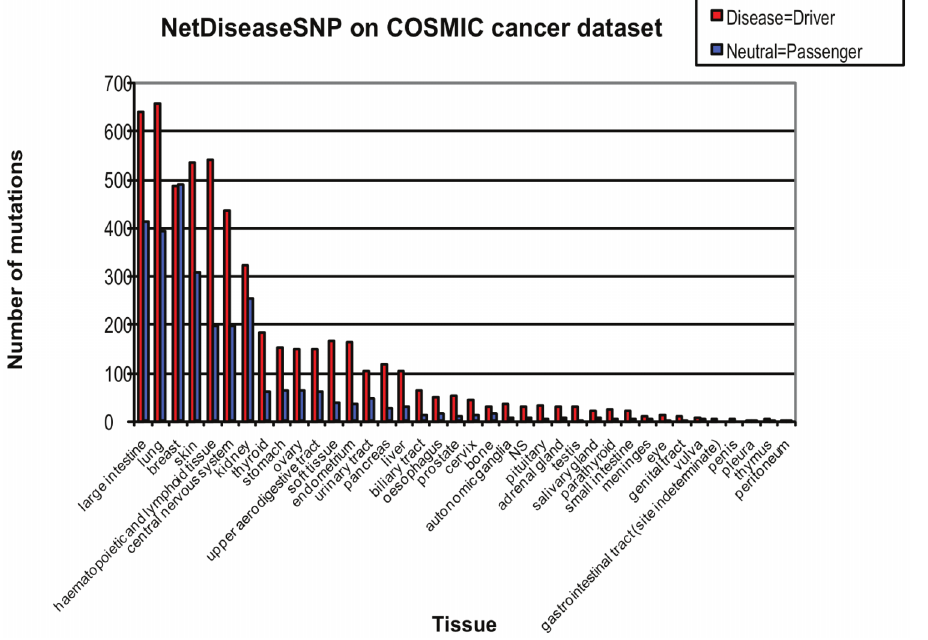
Figure 2. Prediction by NetDiseaseSNP on COSMIC. Number of predicted passenger (neutral) and driver (disease) mutations for the different tissue types in the COSMIC cancer dataset. Our recommendation that predicted disease mutations are ‘drivers’ further suggests that while breast cancer shows almost an equal number of driver and passenger mutations other cancer types are more enriched for ‘drivers’ — at least in the COSMIC dataset.